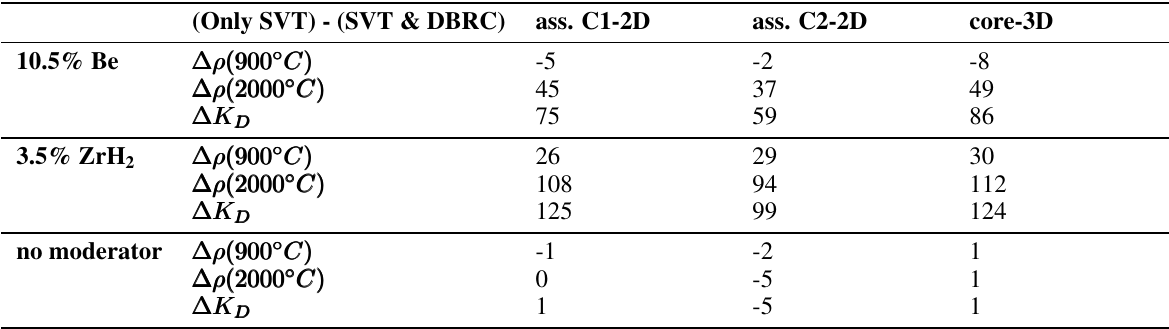
Table 1: Differences in pcm between pointwise T4 reference calculations with ”only SVT” and ”DBRC & SVT” scattering